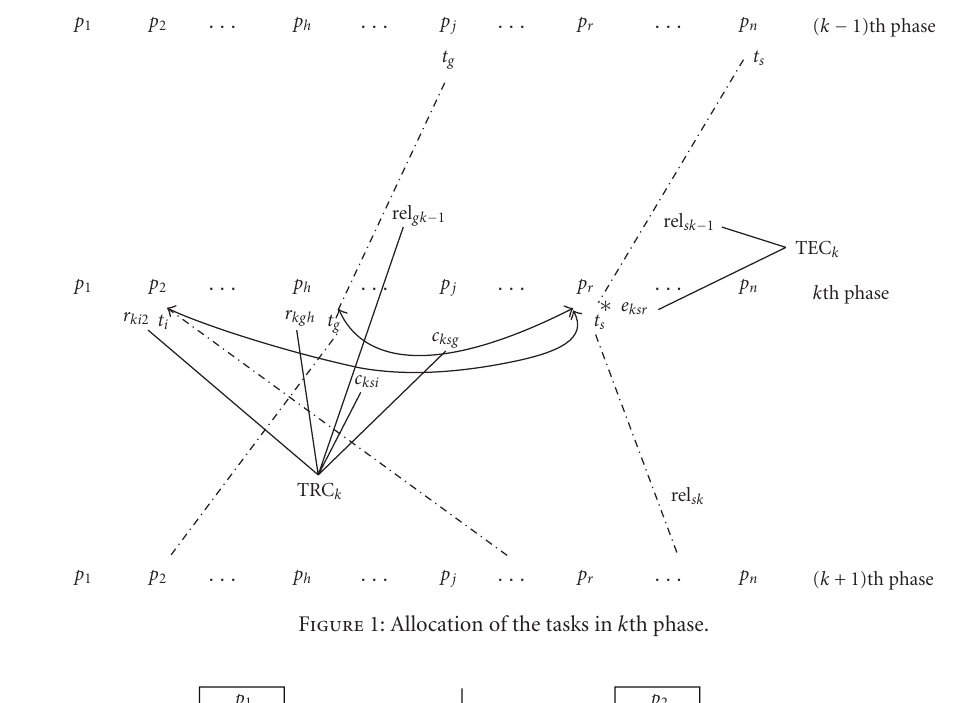
Figure 1: Allocation of the tasks in k th phase.